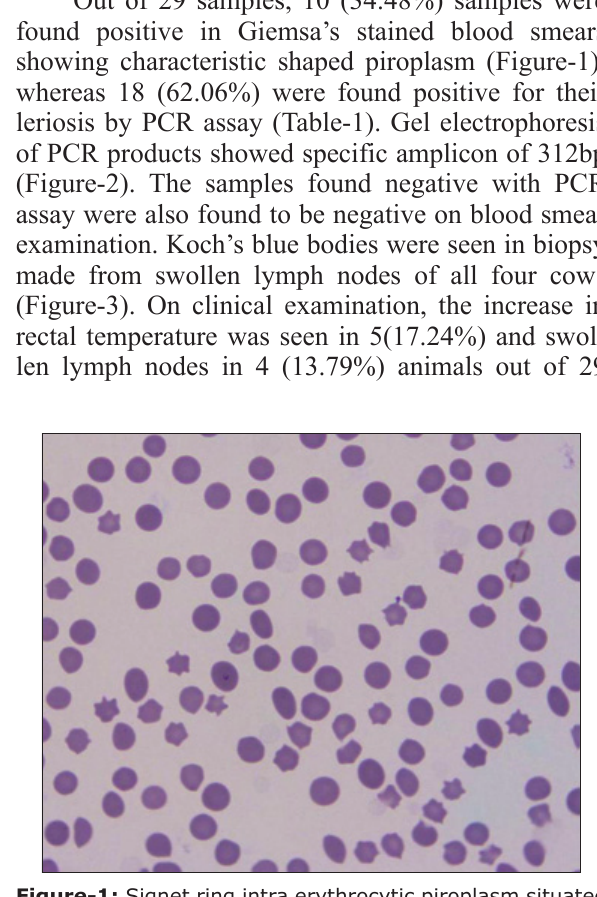
Figure-1: Signet ring intra erythrocytic piroplasm situated on or near the margin of the